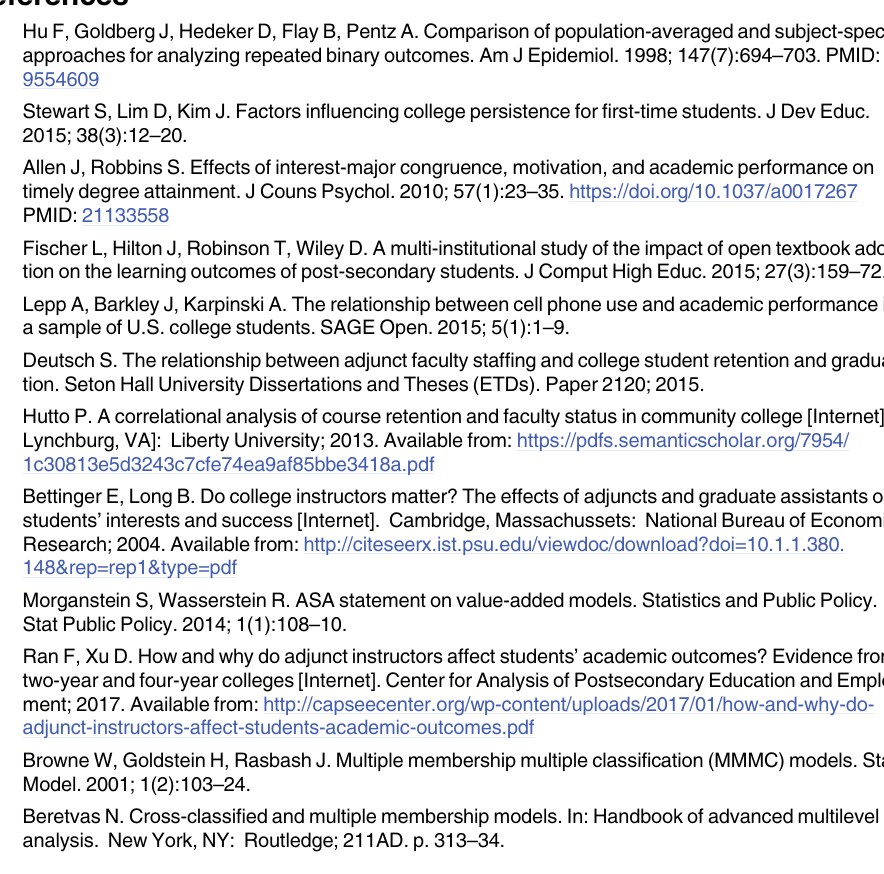
S1 Appendix. Tables for DIC comparisons and posterior distributions of regression coeffi- cients. The document includes tables with DIC values different combinations of random effects for both models and the Markov Chains and posterior distributions for the regression coefficients of both